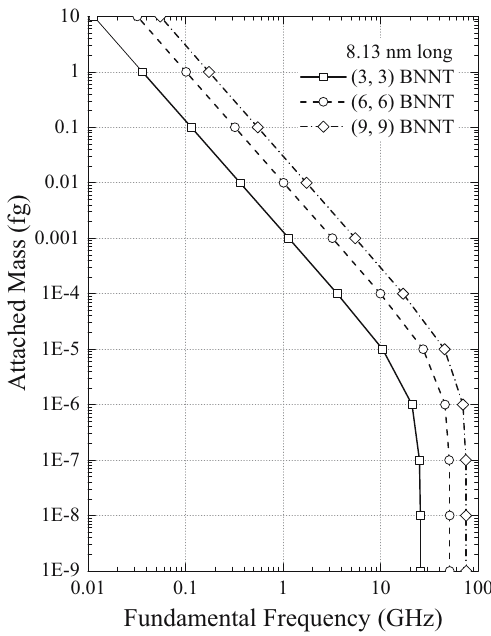
Figure 7: Resonant frequencies for ( 3,3 ) , ( 6,6 ) , and ( 9,9 ) cantilevered SW - BNNT with length 8.13 nm for di ff erent attached masses.